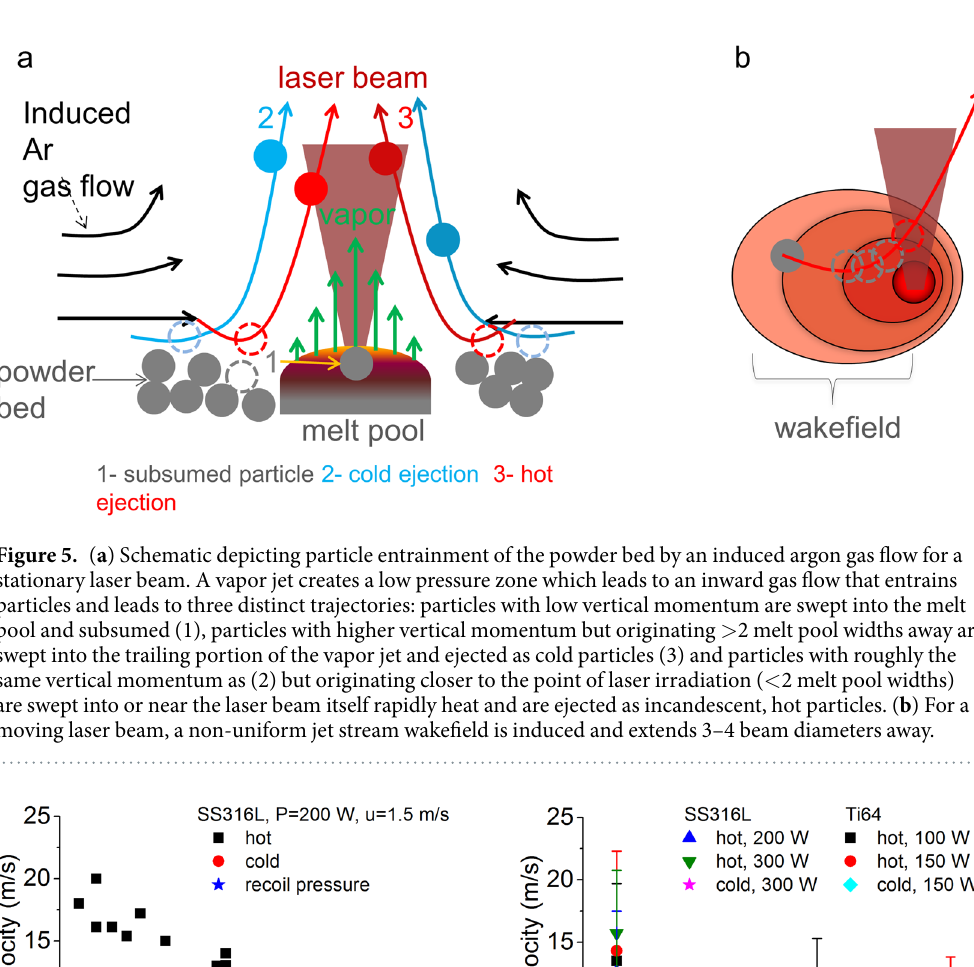
In Ar, the drag forces decrease the height that the particle reaches but do not change the flight time appreciably. The time t c ≈ 13 ms (Supplementary Equation S3) is much shorter than the flight time and most of the droplets fall down as solid spherical particles, preserving the shape developed during flight. To further analyze the spatter characteristics, we tracked the ejected motion frame-by-frame using MtrackJ (see Methods for details). As previously noted, it is not possible to resolve the angular trajectories completely using one camera, and therefore the velocities calculated here are stereographic projections of velocities onto the plane perpendicular to the camera line of sight. Figure 6a shows a velocity-size distribution for SS316L at P = 200 W and u = 1.5 m/s. The hot particle ejections due to entrainment had projected velocities in the range 6–20 m/s dependent on particle size which is determined by taking 1D intensity line-out profile and fitted to a FWHM Gaussian diameter. The hot particle velocities are consistent with the PIV data in Fig. 1e,f. For cold particle ejections due to entrainment, the velocities range from 2–4 m/s and do not appear to vary much with particle size. Melt pool ejections from vapor recoil pressure (and not involving an entrainment effect) are 3–8 m/s inversely dependent on the size. Figure 6b displays velocities for SS316L and Ti64 as function of the scan speed